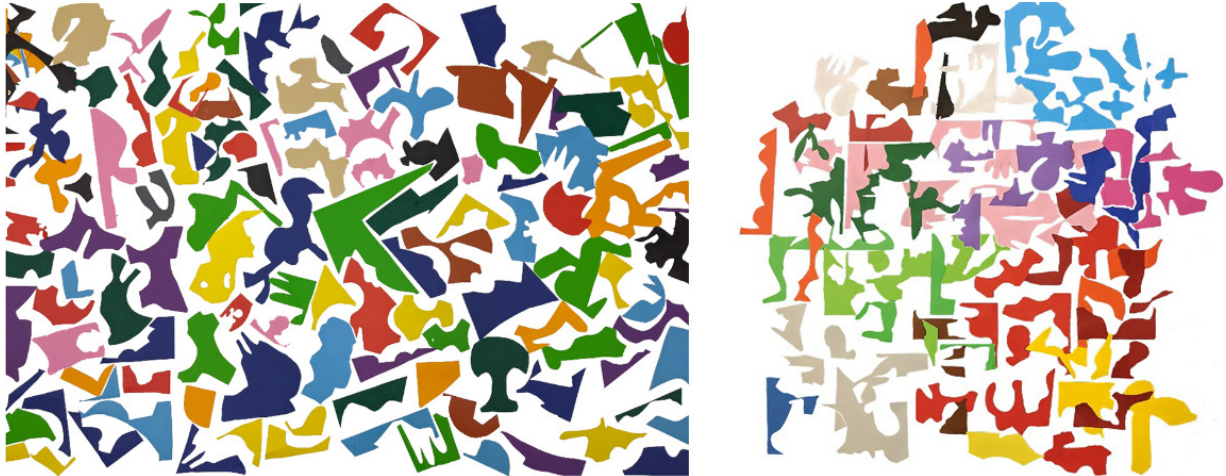
Figure 8. Two IM landscapes: The Colour and Shape Heist‐Goor workshops 1 and 2, series 1 outcomes. Source: Ruth